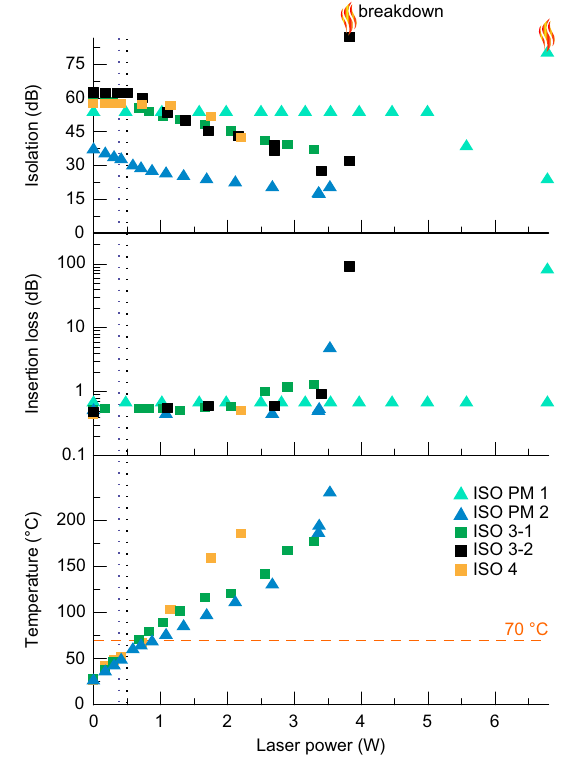
FIG. 3. Isolators’ parameters under testing. The points repre- sent the minimum isolation value, maximum insertion loss value, and highest surface temperature achieved at each applied power of the HPL. The temperature is only measured for three sam- ples. The leftmost vertical dotted line is the maximum specified operating power of 300 mW for ISO PM 2. The rightmost ver- tical dotted line is the maximum specified operating power of 500 mW for the other samples.